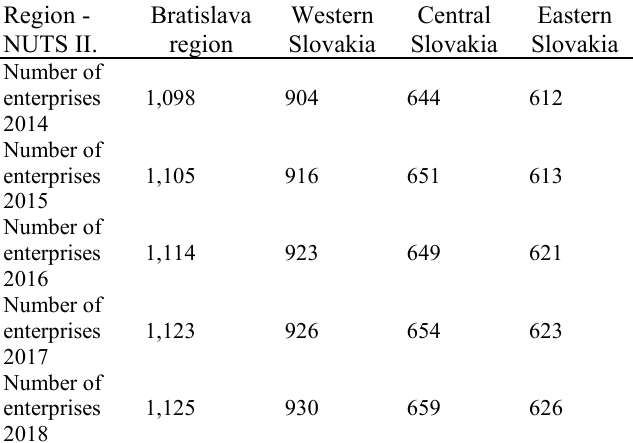
Table 1. Regional structure of the enterprises over